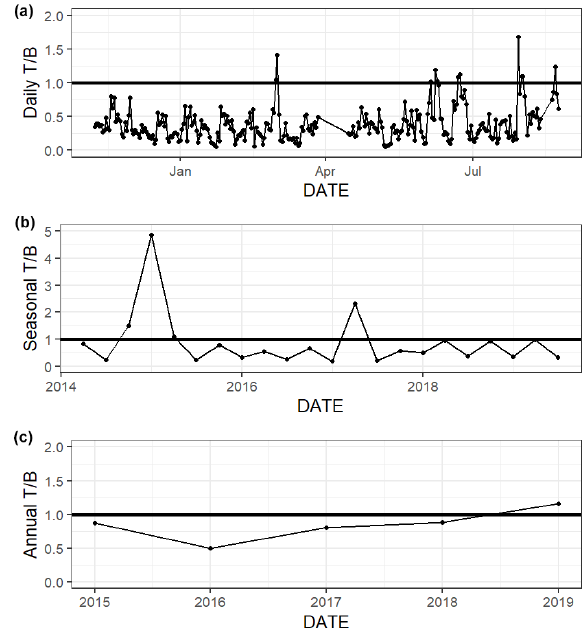
Figure 6. Thermal versus nonthermal control on p CO 2 daily (a) , seasonal (b) , and annual (c) timescales using both continuous sen- sor data (daily, from 8 November 2016 to 3 August 2017) and dis- crete sample data (seasonal and annual, from 2 May 2014–25 Febru- ary